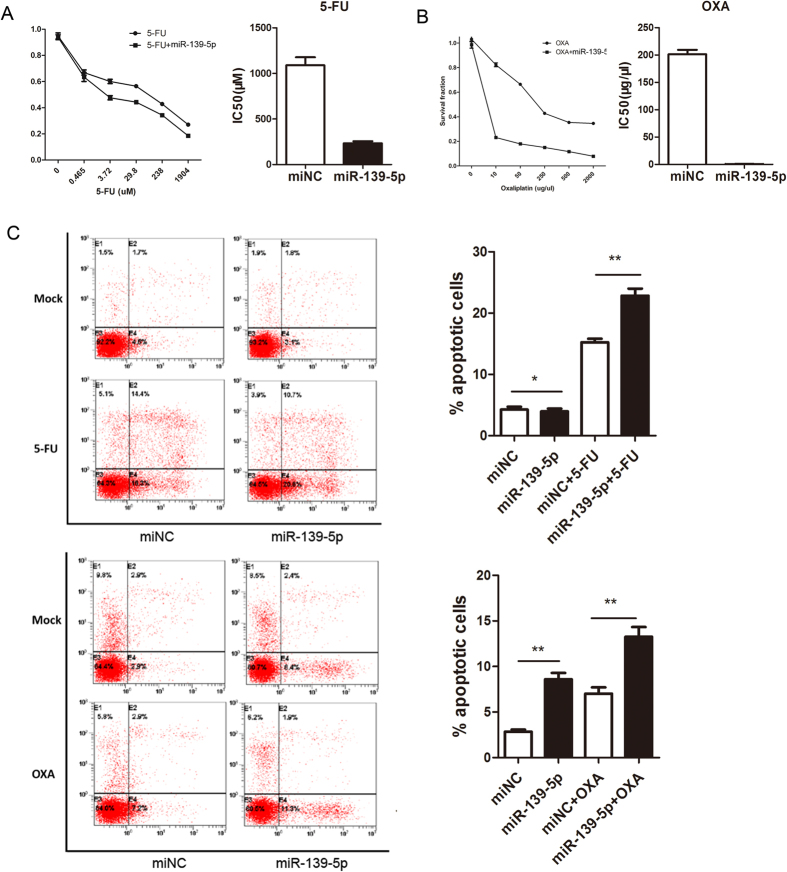
miR-139-5p enhances chemotherapeutic sensitivity in colon cancer cells.(A,B) miR-139-5p expression significantly enhanced the sensitivity of HCT116 to 5-FU and OXA and significantly reduced their IC50 based on the CCK-8 assay. (C) miR-139-5p-transfected cells showed greater sensitivity towards 5-FU and OXA, with more cells undergoing apoptosis after the treatment (*P > 0.05, **P < 0.05).